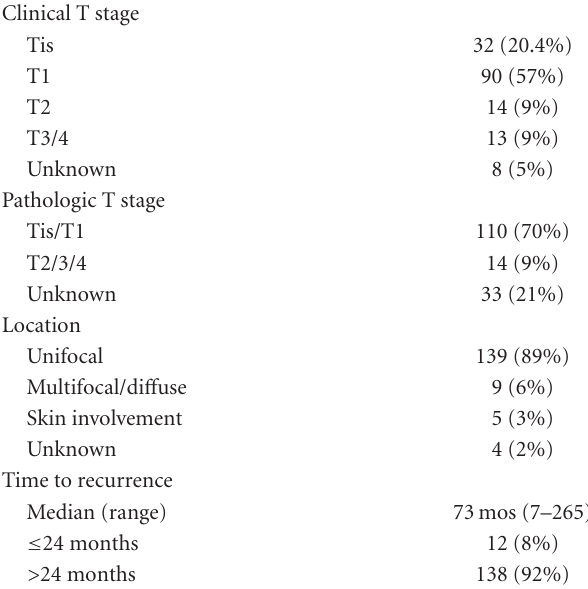
Table 3: Comparison of tumor characteristics between initial and recurrent